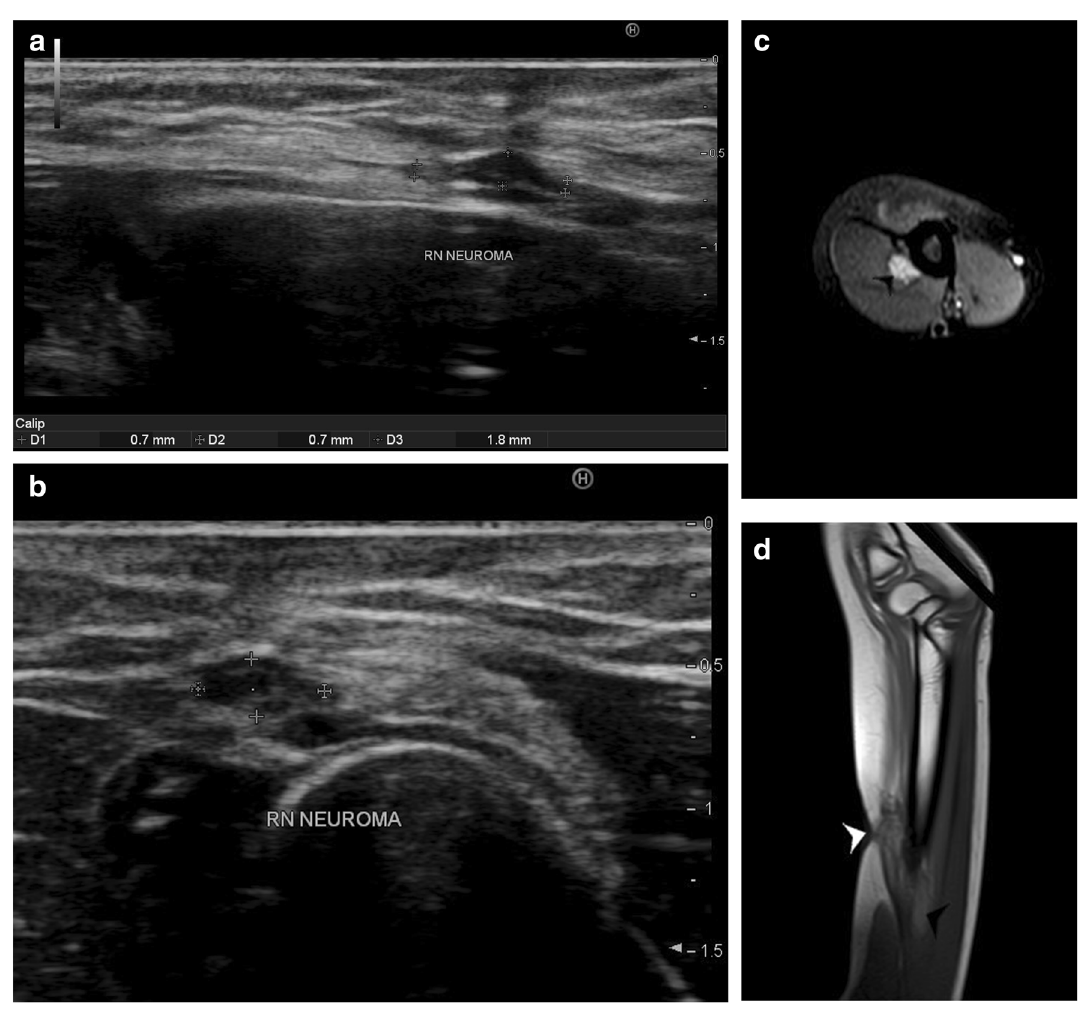
Fig. 4 a Focal fusiform thickening of radial nerve is noted (D3 marker) with normal calibre proximally and distally (D1 and D2 markers). The nerve is hypoechoic at the site of enlargement of the nerve. This anatomical abnormality was noted just deep to the scar at the site of bite on the skin. b Short axis view of focal thickening suggestive of radial nerve neuroma (between cross marks) seen distal to the spiral groove. The nerve is seen lying between the brachialis and brachioradialis. c Axial PD fat saturated sequence of the same patient